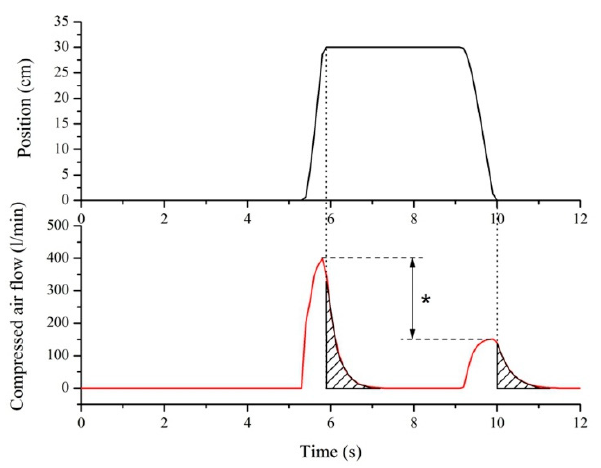
Figure 2. Compressed air flow when a supply pressure of 600 kPa is used in the working stroke and 300 kPa in the return stroke.